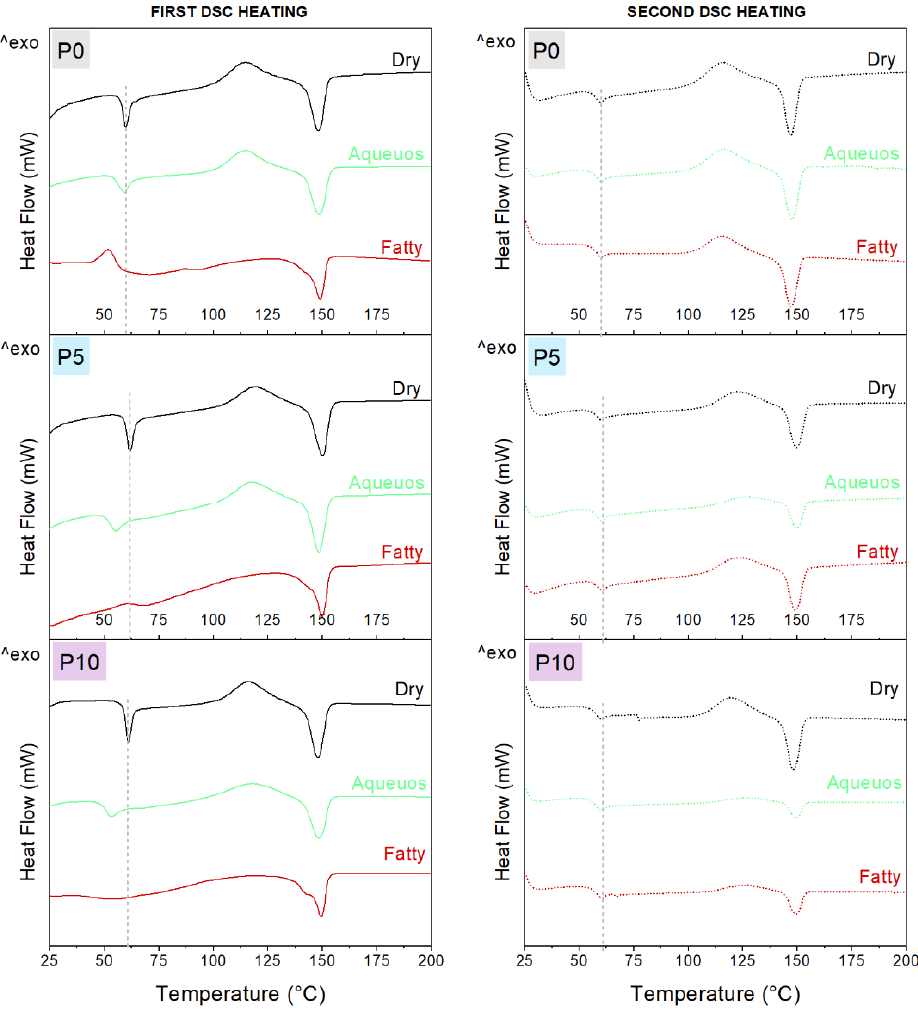
Figure 3. Thermal properties of dry films and after immersion in aqueous and fatty simulants for 48 h at 25 °C.